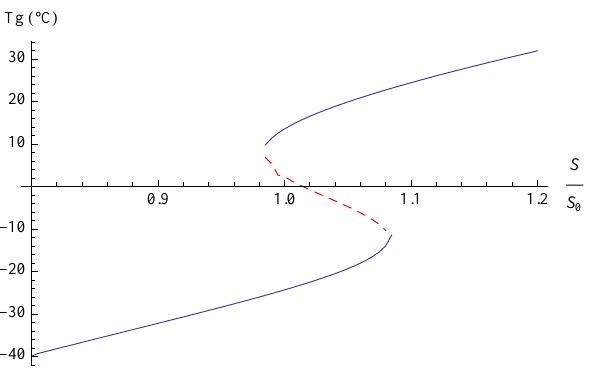
Fig. 5. Bifurcation diagram of the bulk aerodynamic formula model. T G , T P and T S are plotted against S/S 0 when they exist. Stable fixed points are plotted in blue while the unstable solution is in dotted red. This figure clearly shows that two saddle-node bifur- cations occur at respectively S ≈ 0.98 S 0 and S ≈ 1.08 S 0 .